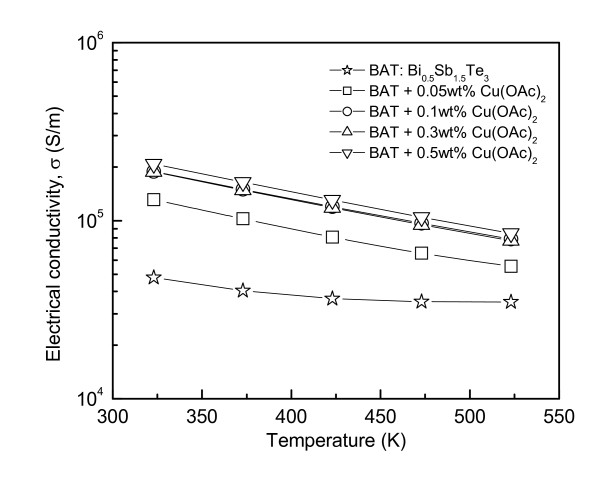
Electrical conductivity of Cu-dispersed BiBi0.5Sb1.5Te3.